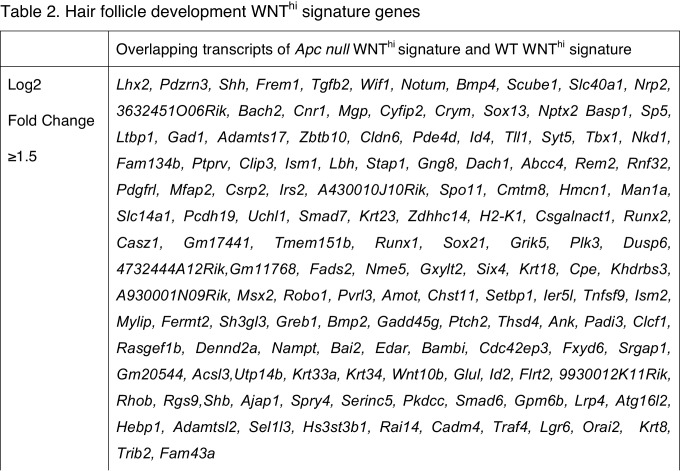
Figure 3—figure supplement 2—source data 1.WNThi signature genes in hair follicle development.Shown is a list of transcripts that are shared between the Apc null WNThi signature and the wild-type WNThi signature.